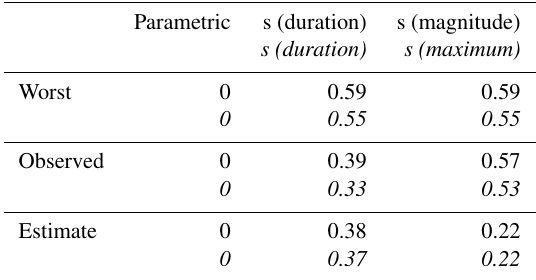
Table A2. Concurvity between smooth functions of the predictors in the GAM analysing flow contribution by the RE ( Q bin ) for Alge- ciras (regular text) and Mula (italic text). Zero means no concurvity among covariates, and 1 means complete